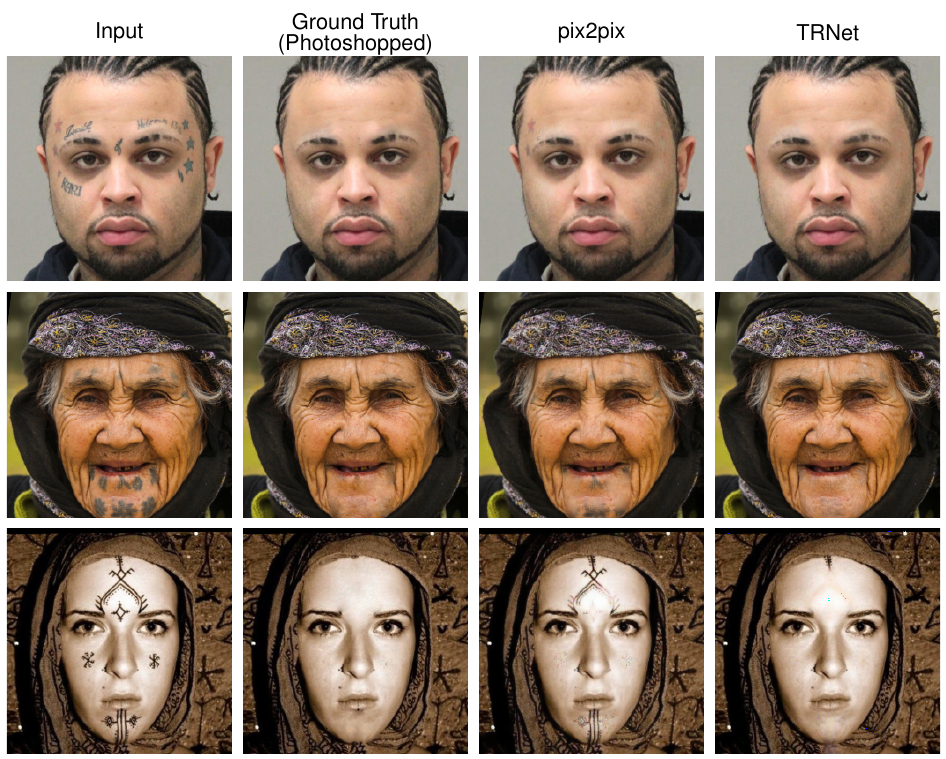
Figure 14. Examples of using deep learning-based algorithms for facial tattoo removal. Best viewed in electronic format (zoomed in).